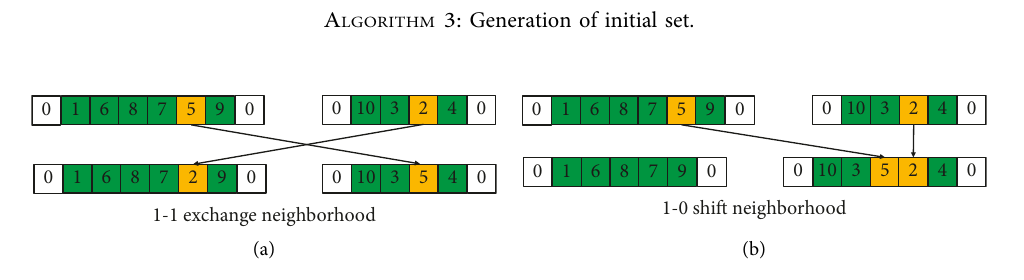
Figure 3: Neighborhood operators. (a) 1–1 exchange neighbourhood. (b) 1–0 shift